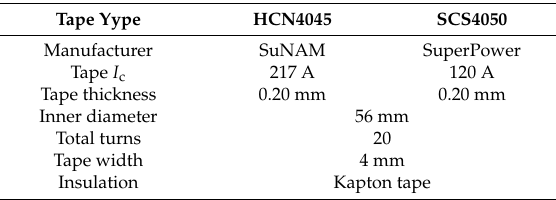
Table 1. Specifications of the coils.